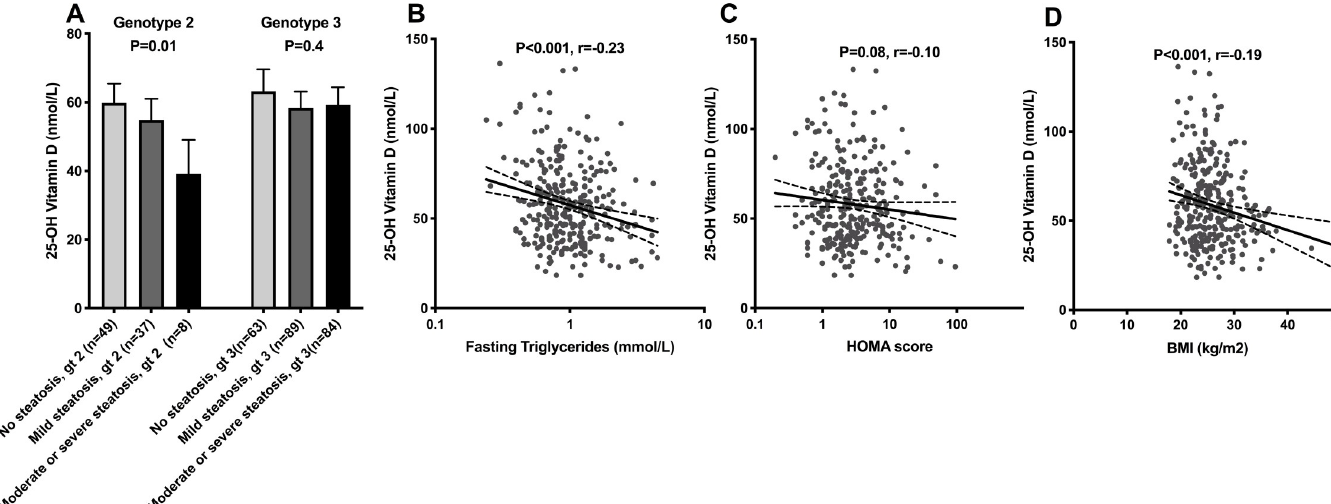
Fig 3. 25-hydroxy vitamin D and liver steatosis. Bar chart for 25-hydroxy vitamin D and liver steatosis severity is shown for the different hepatitis C virus genotypes (A). Also scatter plots for 25-hydroxy vitamin D and fasting triglycerides (B), HOMA-score (C) and BMI (D) are shown. Mean concentration and 95% confidence interval is shown. Statistical significance determined by One Way ANOVA and Pearson’s test.